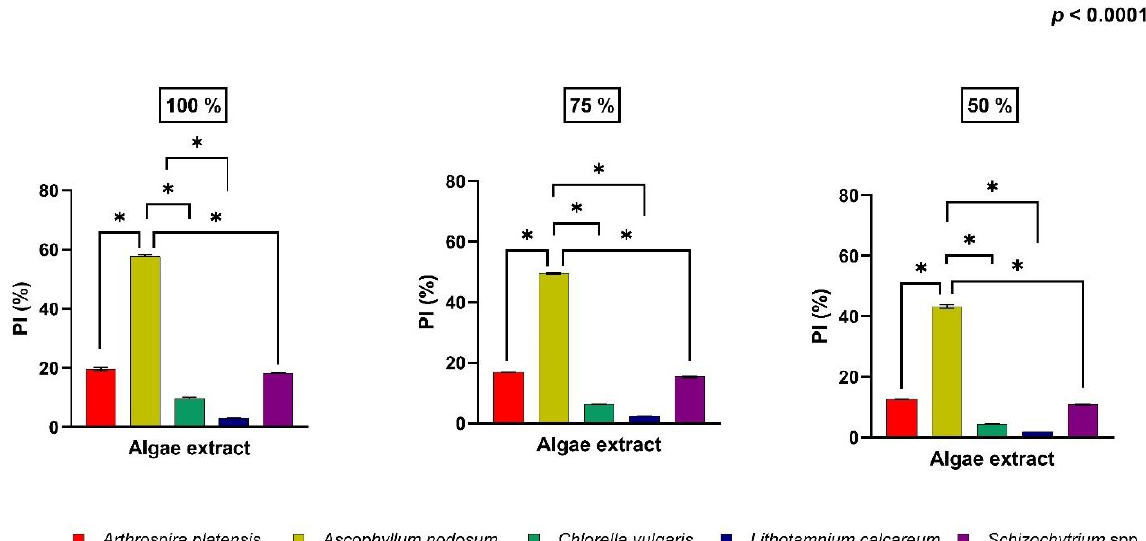
Figure 1. Percentage of inhibition (PI%) of radical scavenging activity at three different concentrations (100%; 75%; 50%) of four algal and cynobacterial extracts tested ( Arthrospira platensis; Ascophyllum nodosum; Chlorella vulgaris; Lithothamnium calcareum and Schizochytrium spp.). Data are shown as means and standard deviations. * Asterisk indicates statistically significant differences among tested compounds (Treatment p < 0.0001).